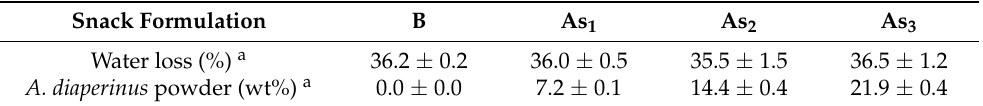
Table 2. Water loss of the different 3D-printed baked snacks and the concentration of insect powder after the baking process. Abbreviations used: B, blank snack with 0% insect powder; As 1 , snack with 7.2% of A. diaperinus powder; As 2 , snack with 14.4% of A. diaperinus powder; As 3 , snack with 21.9% of A. diaperinus powder.